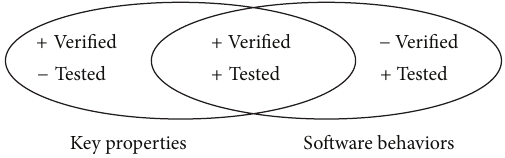
Figure 1: Three kinds of effects for the traditional software valida- tion